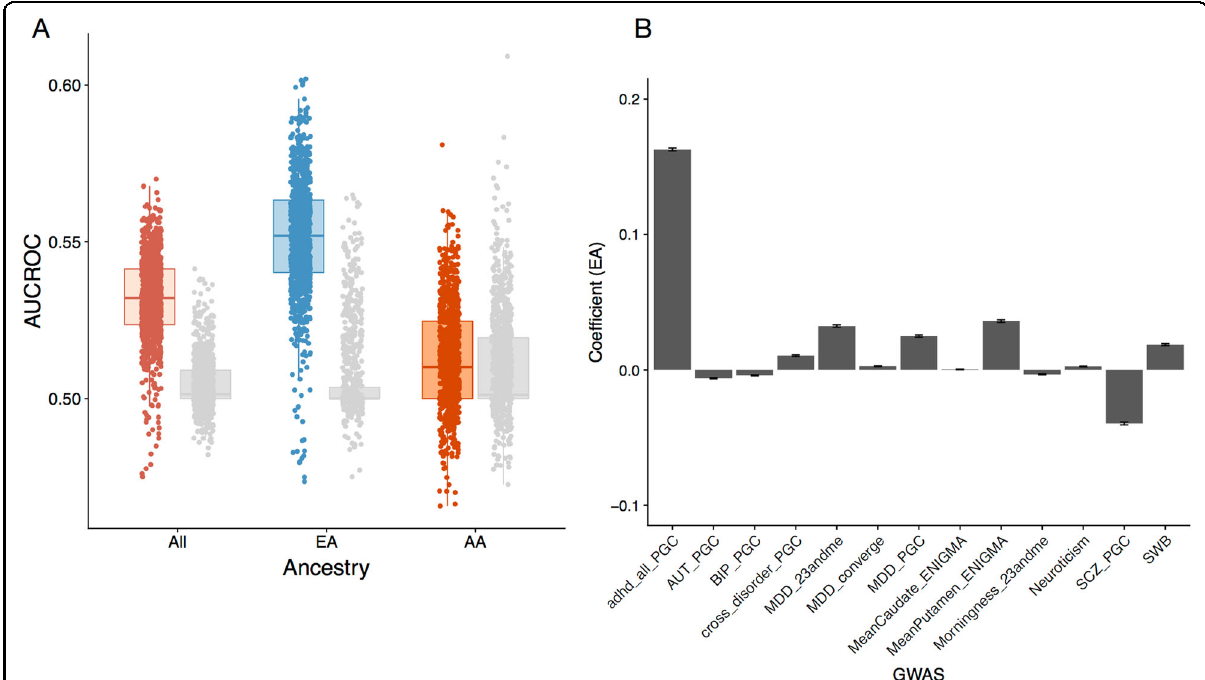
Fig. 2 Multivariate classi fi cation of PS, by ancestry. A AUCROC for each elastic net model trained on 70% and tested on the remaining 30% of data in All (pink), EA (blue) and AA (orange). Boxplots indicate the median and the lower and upper hinges correspond to the fi rst and third quartiles. The grey dots and boxplots refer to fi ts of permuted datasets within each ancestry group. The observed predictive power is driven by the EA cohort.